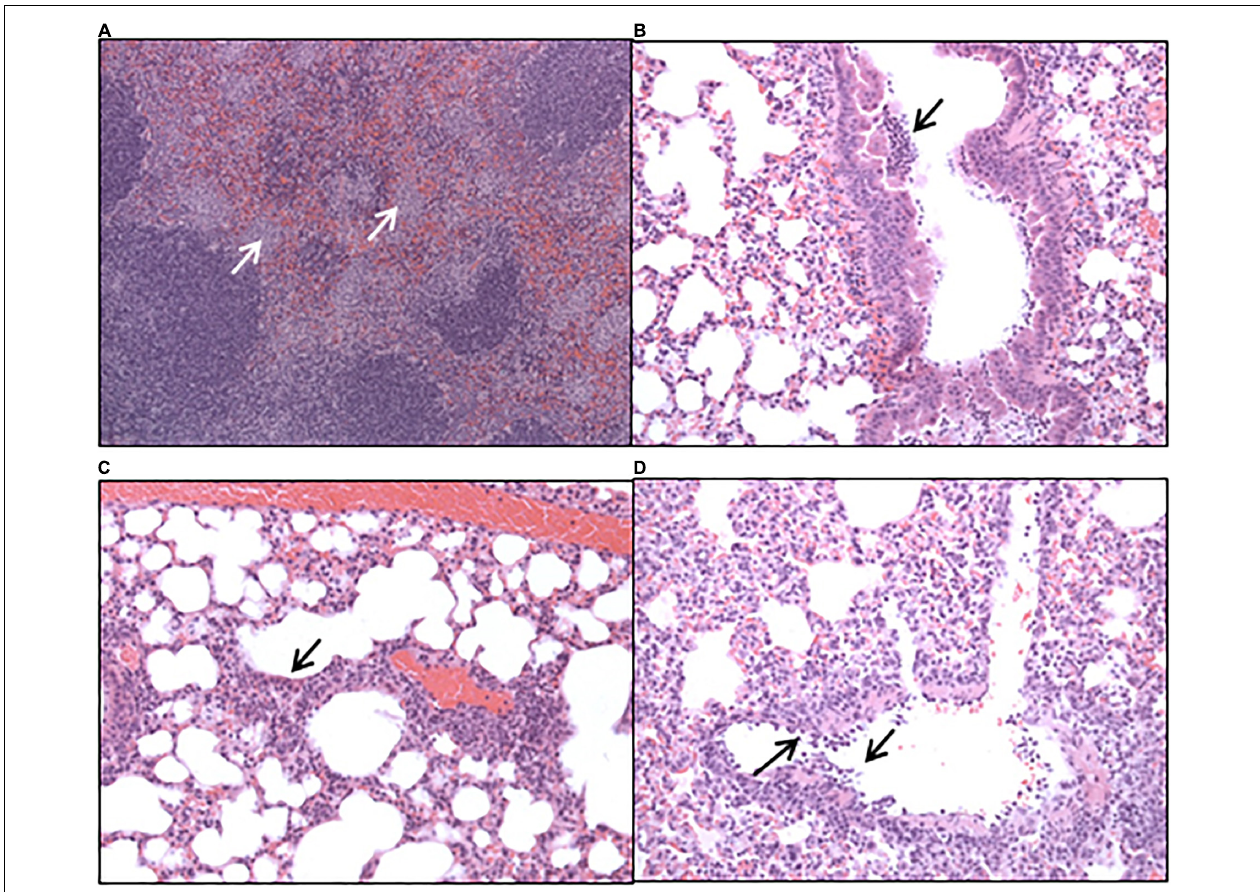
FIGURE 4 | Hematoxylin-and-eosin-stained tissues harvested from mice infected with C. burnetii and treated with the vehicle control. (A) Spleen harvested at day 8 post-challenge showing marked, multifocal, granulomatous splenitis (B) lung harvested at day 4 post-challenge showing acute, focal bronchiolitis and (C) acute, focal alveolitis. (D) Lung harvested at day 8 post-challenge showing vasculitis.